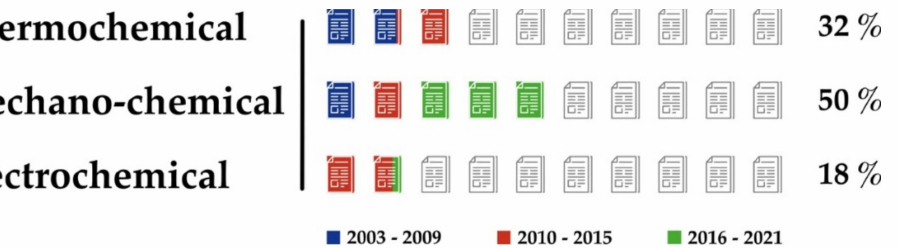
Figure 3. Infographic view of the type of process reported in the research articles, published since 2000, dedicated to NaBH 4 regeneration.